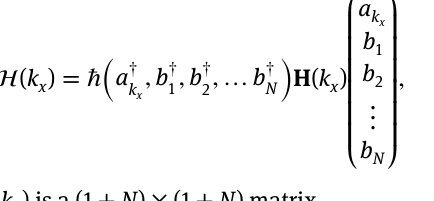
= 𝜗 = 0, as illustrated in along the x -axis, i.e. when 𝜑 i i Figure 1(e) for a molecule with z = 0. Figure 1(e) also dependence of the interaction highlights the k x